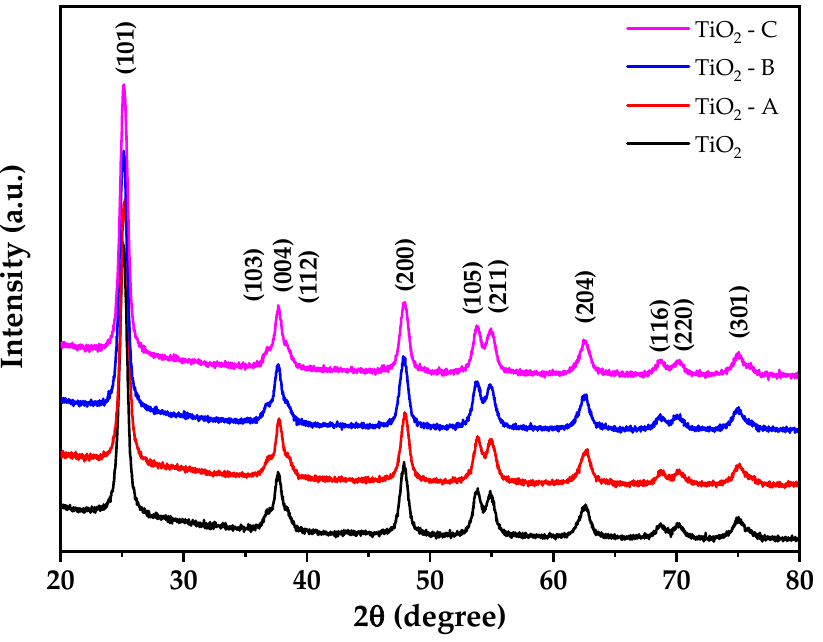
Figure 2. X-ray diffraction patterns of pure and doped TiO 2 . Table 1. Structural parameters of iron-doped TiO 2 nanoparticles.